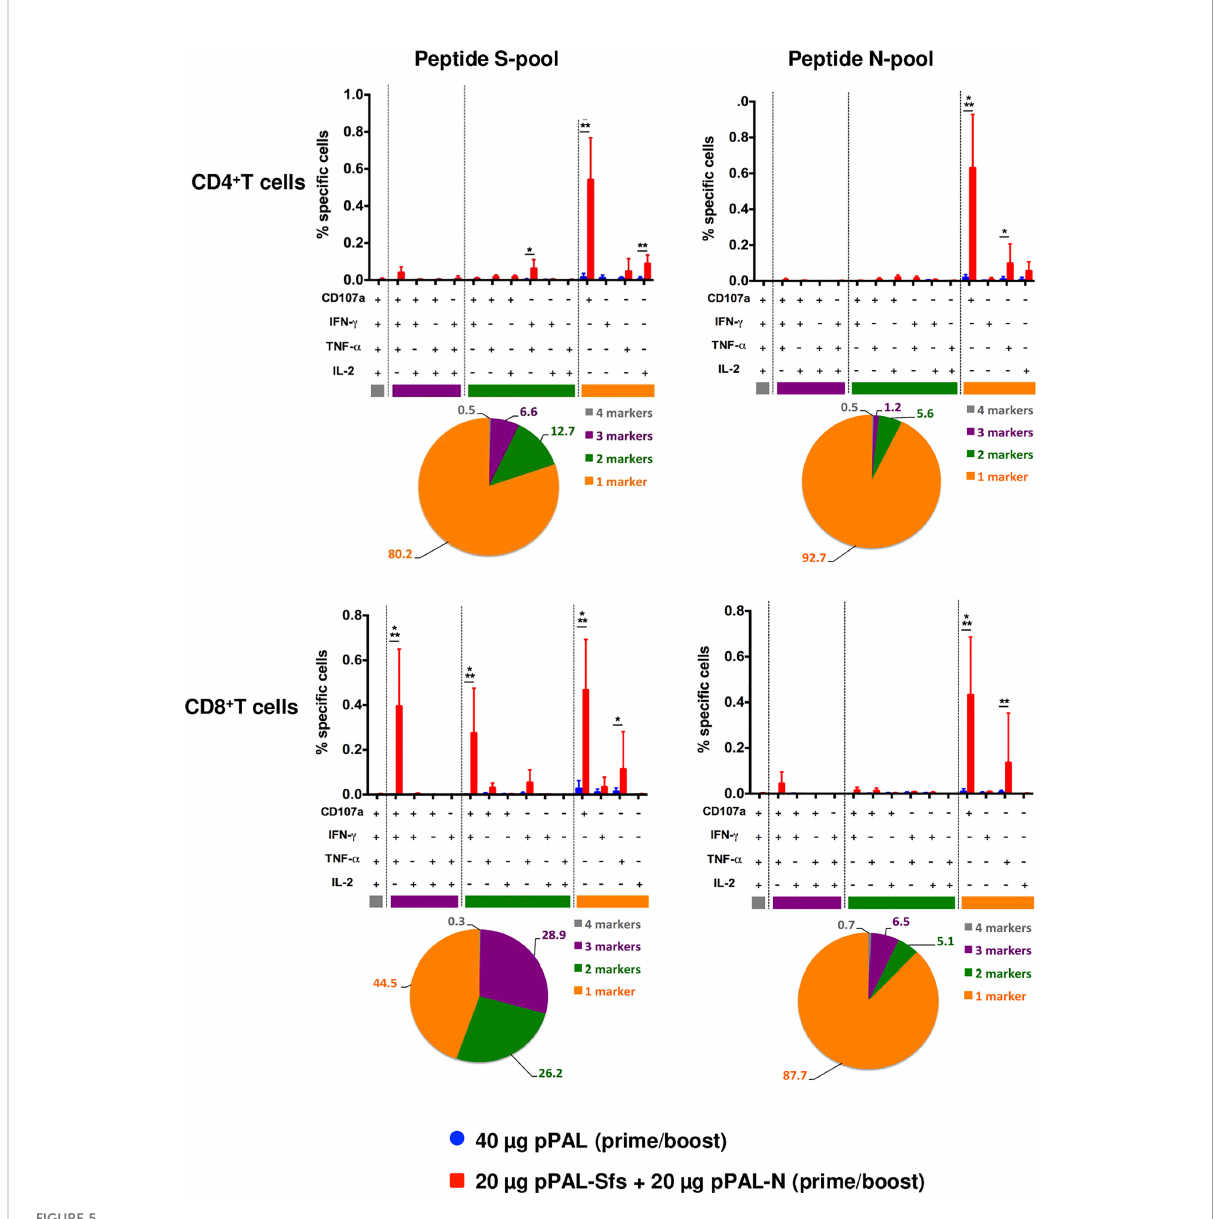
FIGURE 5 Polyfunctionality analysis of speci fi c CD3 + CD4 + and CD3 + CD8 + T cell populations stimulated by pPAL-Sfs + pPAL-N immunization in C57BL/6J mice. Analyses of concomitant expression of CD107a, IFN- g , TNF- a , and IL-2 in CD3 + CD4 + T cells and CD3 + CD8 + T cells in response to N peptide pool or S peptide pool stimulation. Pie charts split the percentage of T cells expressing either 1, 2, 3, or 4 markers upon stimulation. Statistical inference using Two-way ANOVA with Fisher ’ s LD post-hoc test (*p<0.05; **p<0.01;